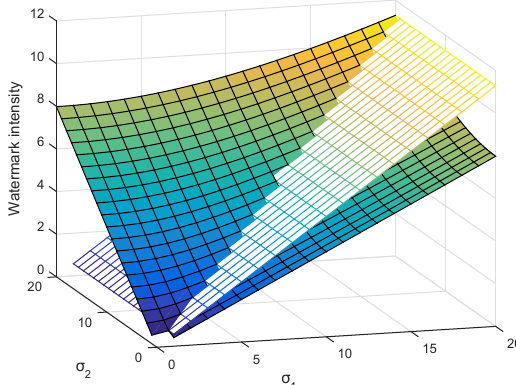
Figure 5. Watermark detection probability vs diffusion coeffi-